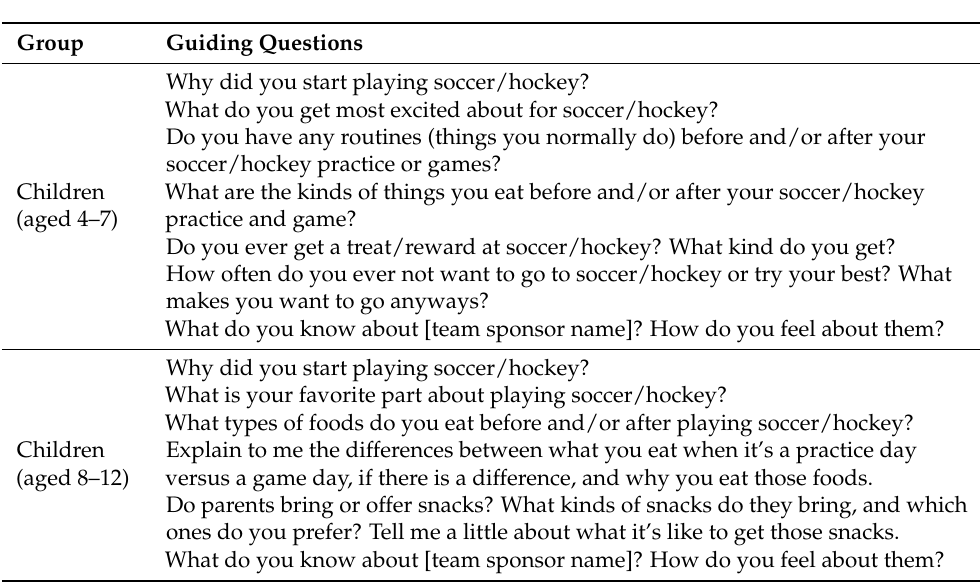
Table 1. Semi-Structured Interview